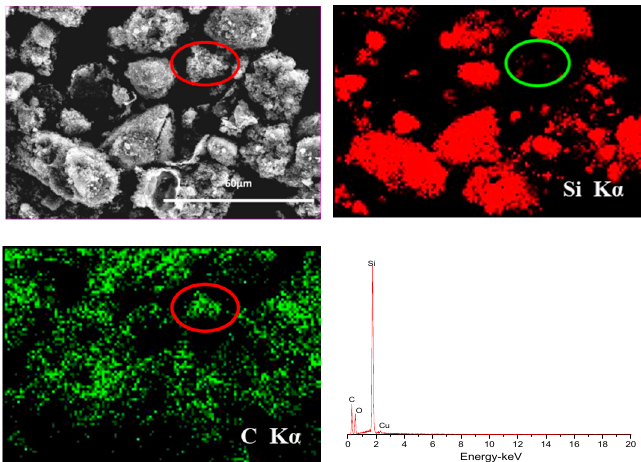
Figure 4. EDS elemental mapping (Si and C) and EDS spectrum for the selected area of the p -Si@C composites with carbon content of 45 wt.%.